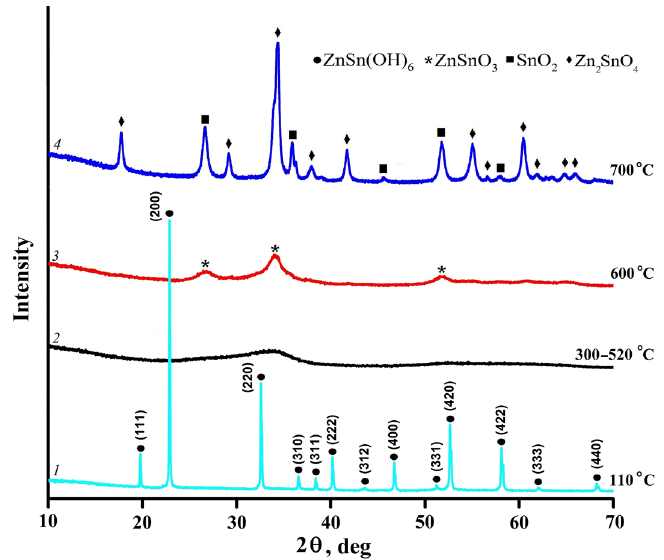
Figure 2. X-ray diffraction patterns of initial ZnSn(OH) 6 (1) and thermolysis products obtained at Figure 2. X-ray di ff raction pa tt erns of initial ZnSn(OH) 6 (1) and thermolysis products obtained at temperatures of 300–520 ◦ C (2), 600 ◦ C (3), and 700 ◦ C temperatures of 300–520 °C (2), 600 °C (3), and 700 °C (4).